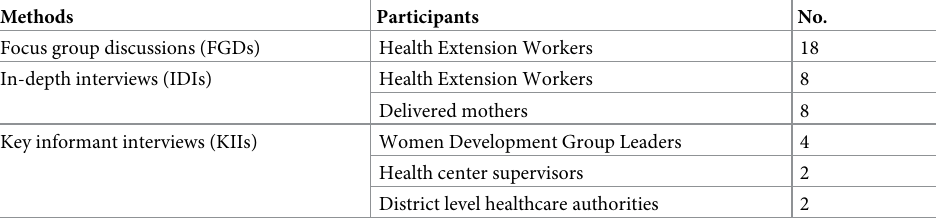
Table 1. Methods of approach and